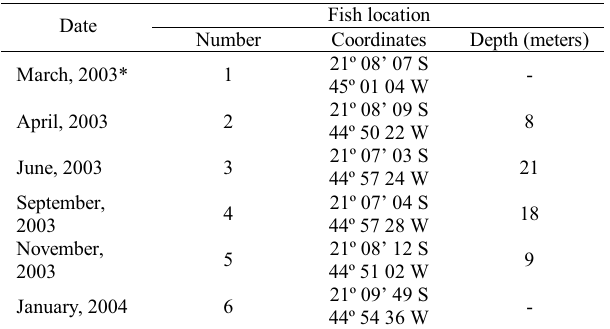
Table 1. Number, coordinates, and depth of locations of the tagged jaú in Funil Reservoir, rio Grande (MG, Brazil). * Re- leased date.